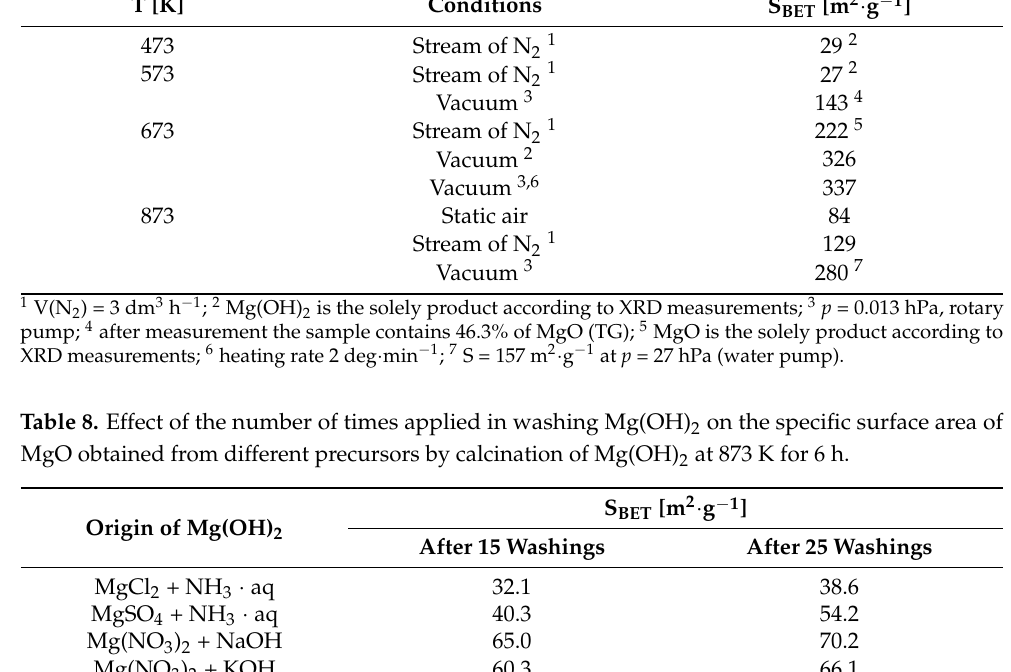
Table 7. Effect of Mg(OH) 2 decomposition conditions on the specific surface area of the obtained MgO. Calcination for 6 h at final temperature, heating rate 10 deg · min − 1 . T [K] Conditions